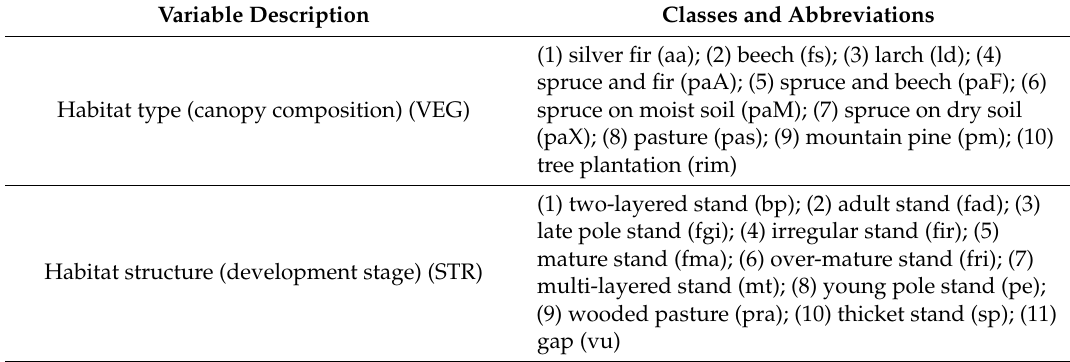
Table 1. Habitat type and structure